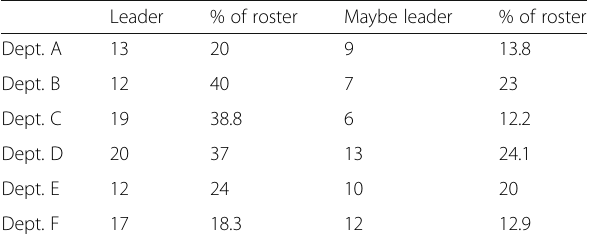
Table 4 Descriptive statistics of individuals identified as leaders and maybe leaders by department